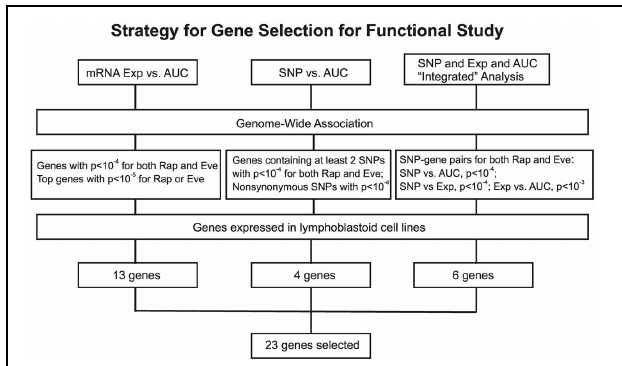
FIGURE 3 | Schematic diagram of the strategy for selecting candidate genes for functional validation. A total of 23 candidate genes were selected based on genome-wide associations of expression (Exp) vs. AUC, SNP vs. AUC and an “Integrated” analysis, as described in the